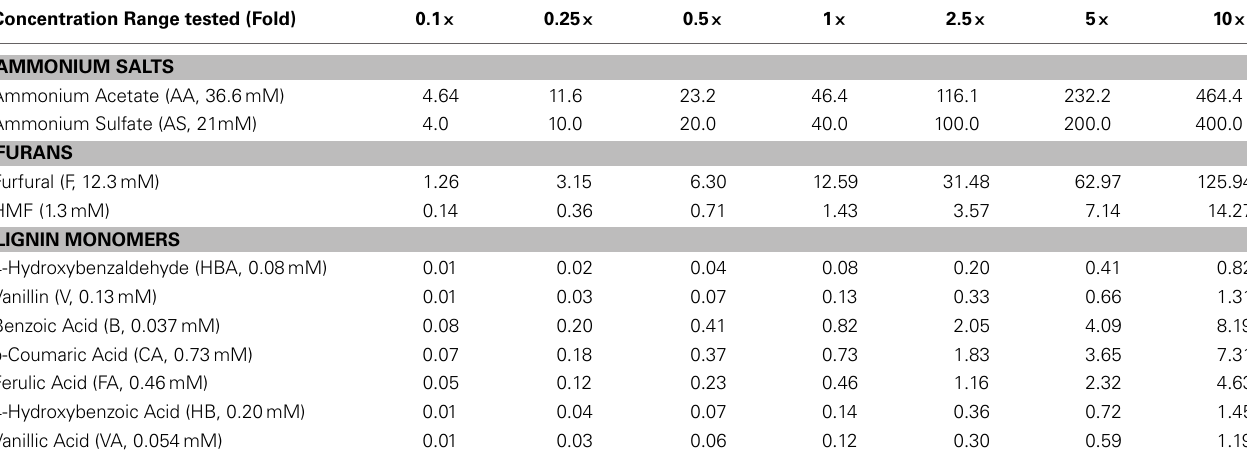
Table 2 | The chemicals and their concentration ranges (mM) selected for toxicity testing. Concentration Range tested (Fold)